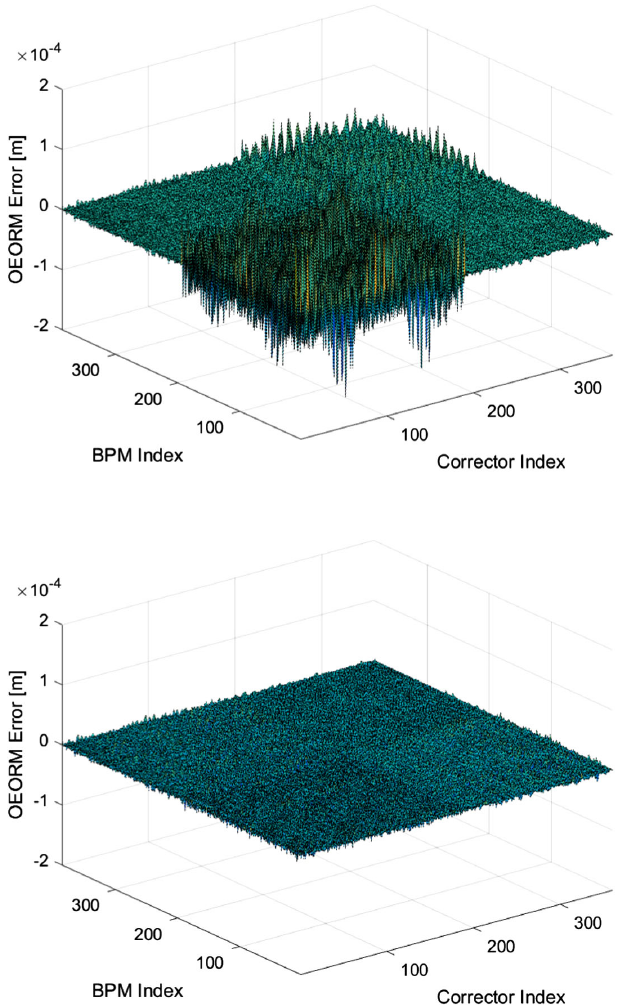
FIG. 9. Difference between measured and model OEORM before (top) and after (bottom) fitting the model. The BPMs and dipole correctors are plotted in the order horizontal followed by vertical .